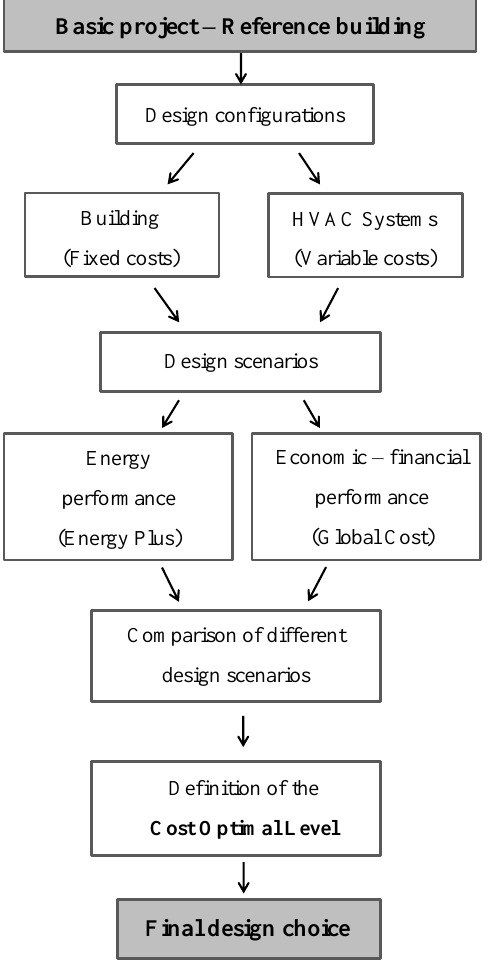
Figure 1. Cost-optimal methodology applied to this study as a decision-making tool for supporting architects’ energy design